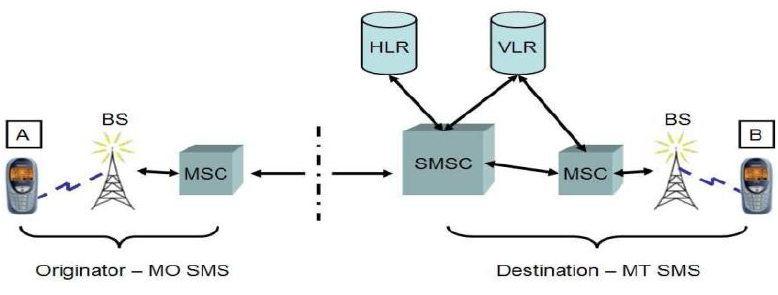
Figure 1: Typical Handset-to-Handset Network Architecture for SMS; Source: Adopted from Zerfos et al.,